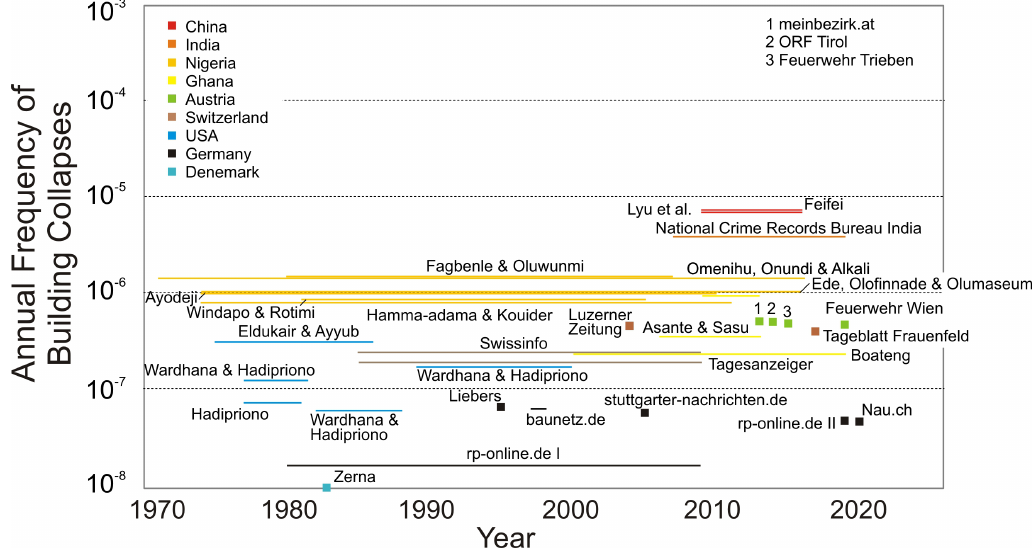
Figure 1. Annual frequency of building collapses based on [13]. The individual references are given in